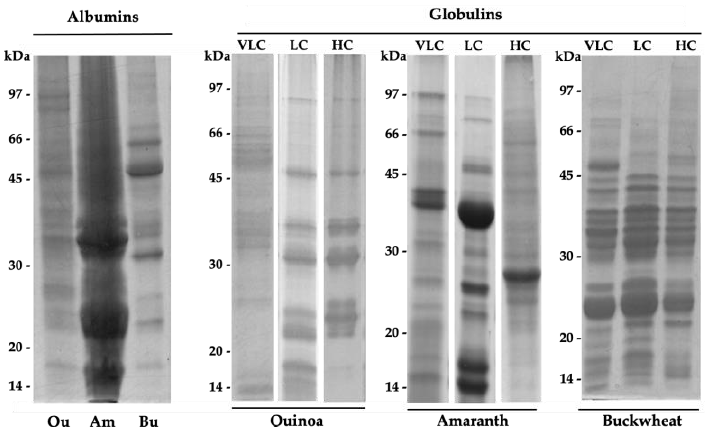
Figure 1. SDS-PAGE analysis of albumins and globulin fractions from quinoa (Qu), amaranth (Am), and buckwheat (Bu) seed proteins. VLC: very low charge; LC: low charge; HC: high charge.